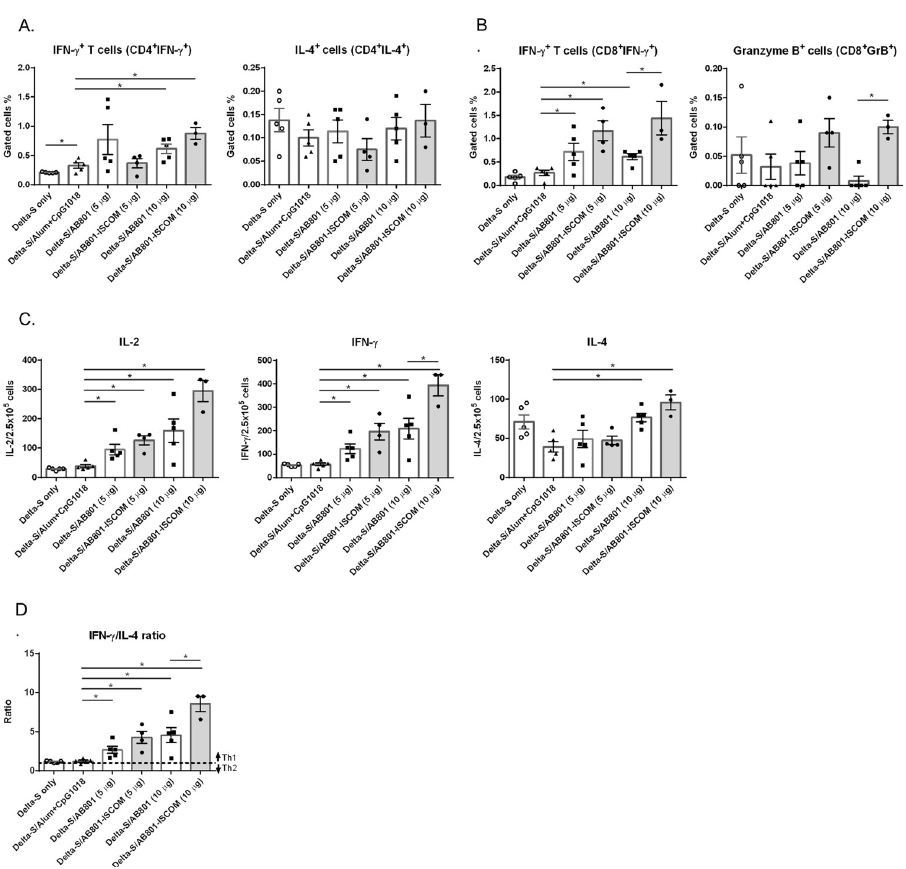
Fig 4. T cell responses in BCVax immunized BALB/c mice. The delta S protein (10 μ g) combined with or without adjuvant candidates of aluminum hydroxide plus CpG 1018 (50 μ g plus 10 μ g, triangle), AB801 (5 or 10 μ g, square), or AB801-ISCOM (5 or 10 μ g, circle, grey bars) were immunized to BALB/c mice on day 0 and day 14, splenocytes were harvested on day 28 for analysis. (A) Flow cytometry analysis of CD4 T cell populations of CD4 + IFN- γ + and CD4 + IL- 4 + cells. (B) CD8 T cell populations of CD8 + IFN- γ + and CD8 + GranzymeB + cells were evaluated using immunized mice splenocytes. (C) The number of IL-2, IFN- γ , and IL-4 secreting cells from immunized splenocytes per 2.5E+5 cells were analyzed by ELISPOT assay. (D) The ratio of IFN- γ /IL-4 of ELISPOT results. Bars represent mean ± SD. Statistically significant differences were indicated ( � p <